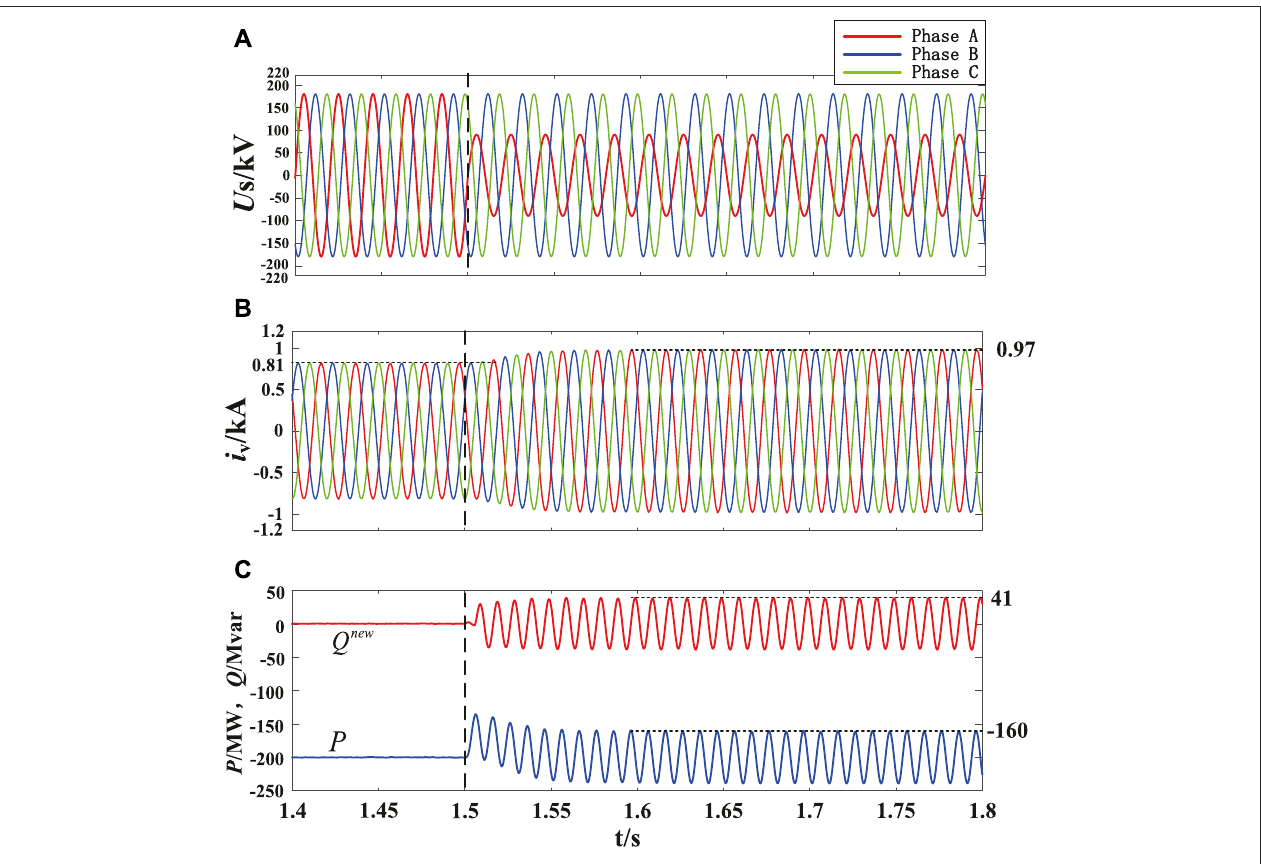
FIGURE 7 | Control performances of restraining negative sequence current of MMC 2 under unbalanced grid condition, (A) AC grid voltage at MMC 2 side, (B) AC grid current output by MMC 2 , (C) active power and ERP output by MMC 2 using the novel ISMVC.